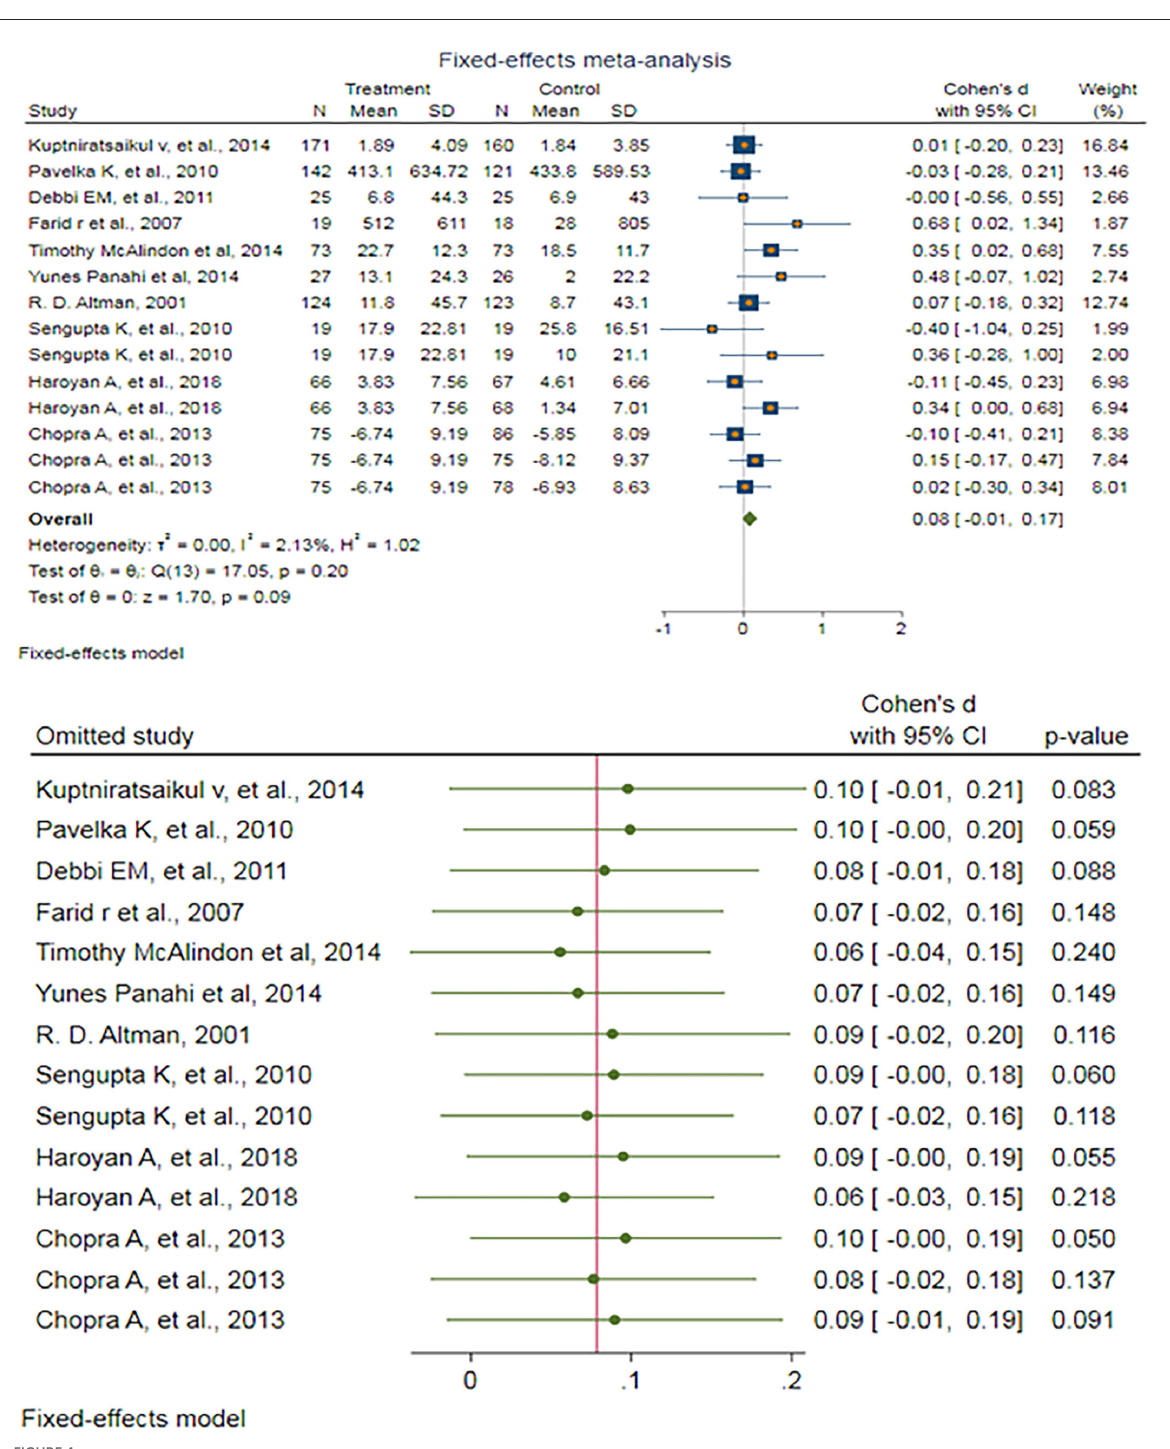
FIGURE4 (UP) A forest plot for the association between antioxidants and the outcomes of interest in OA based on the WOMAC difficulty pain score. (DOWN) Forest plot of sensitivity analysis for the association between antioxidants and the outcomes of interest in OA based on the WOMAC difficulty pain